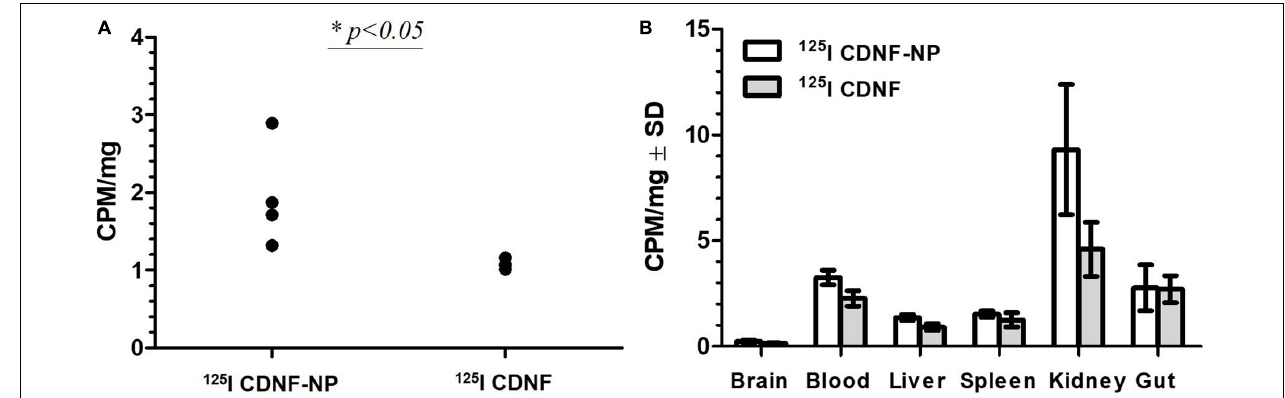
FIGURE 6 | Delivery of 125 I-labeled CDNF through the blood–brain barrier in vivo using nanoparticles [counts per minute (CPM) per mg tissue]. 125 I CDNF was adsorbed on the surface of 200 nm poly(lactic-co-glycolic acid) nanoparticles ( 125 I CDNF-NP) or used without NPs ( 125 I CDNF) and administered subcutaneously in vivo in rats (100 µ l equaling to 954 000 CPM were delivered). Rats were perfused with PBS for 20 min. (A) 125 I CDNF in the brain after 1 h (CPM/mg brain). (B) Distribution of CDNF in different organs after 1 h (CPM per mg tissue). ∗ p < 0.05, n = 4. Unpublished data. Experiments were performed under the permits